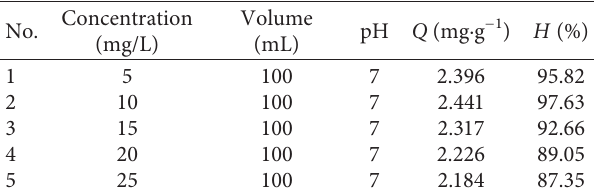
Table 13: Effect of initial concentration on the methylene blue adsorption process.